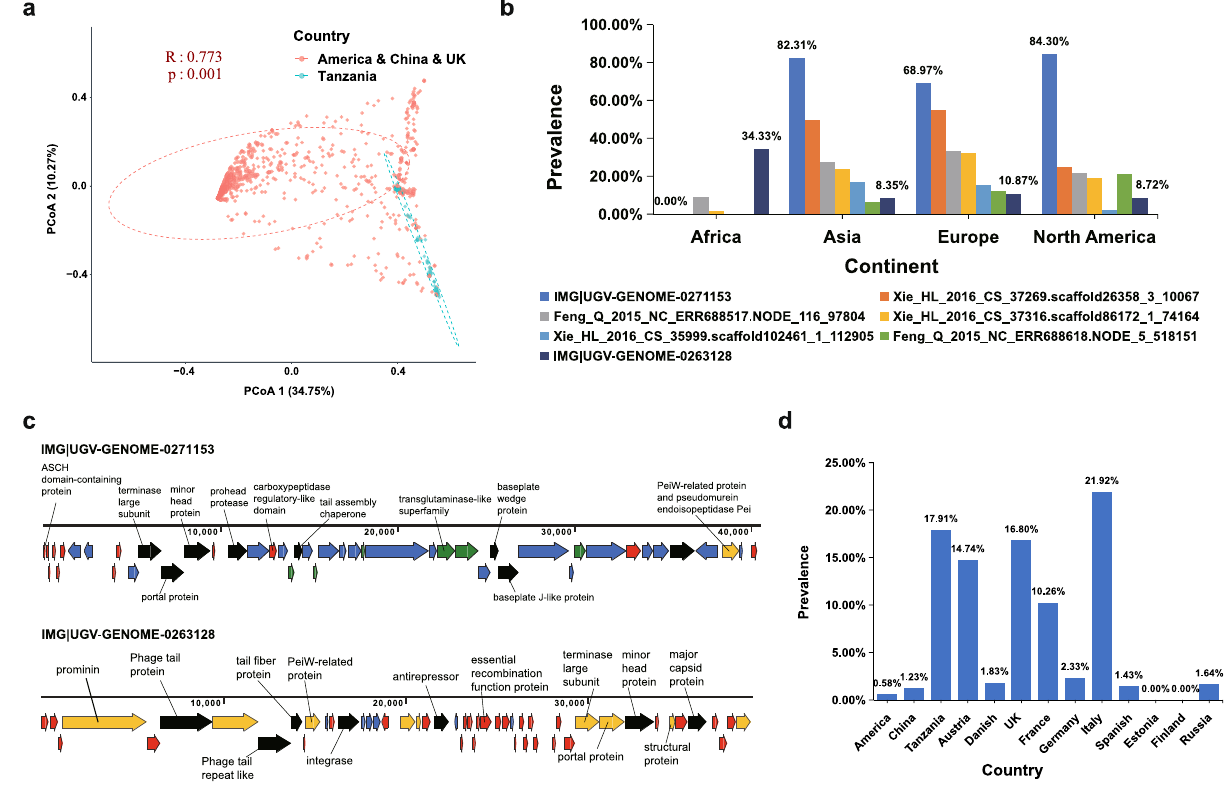
Fig. 2 | Protein clustering network and global distribution of the HGAVD viruses in the human gut. a PCoA of the human gut samples based on the Bray- Curtis distance matrix calculated from the abundance matrix of the HGAVD viru- ses. Each point is colored according to the country. R values were obtained by a two-way analysis of similarities (ANOSIM). b Global distribution of the HGAVD viruses with high prevalence (prevalence>10%). c Genome map of IMG|UGV- GENOME-0271153 and IMG|UGV-GENOME-0263128. Genes are colored based on